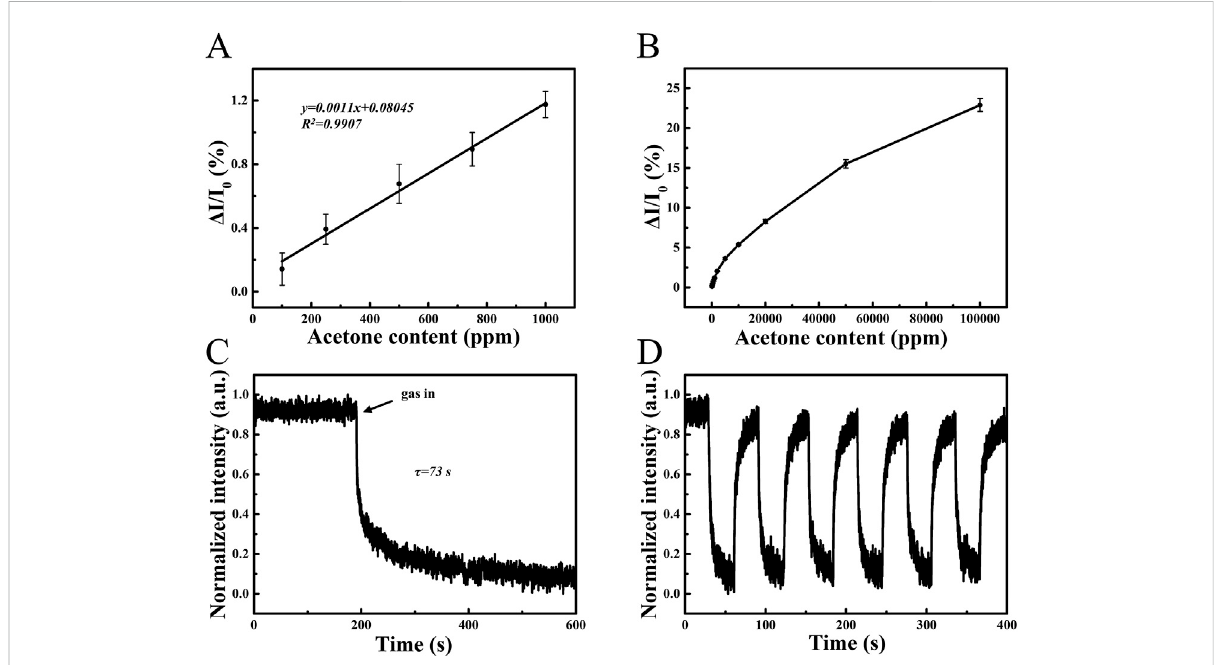
FIGURE 3 (A) Response curves of PS/TPMN samples in acetone vapor at low concentrations. Δ I/I 0 varies linearly with acetone concentration, demonstratingagoodlineardependencywithlowlimitofdetectionof100 ppm.Errorbars,s.d.( n =10); (B) ResponsecurvesofPS/TPMNsamplesin acetone vapor at 100 ppm-100000 ppm. Error bars, s.d. ( n = 10) (C) Single response curves of PS/TPMN samples in acetone vapor at 300000 ppm. The result indicates the sensor response time is 73 s; (D) Continuous multiple response curves of PS/TPMN samples in acetone vapor at 300000 ppm. Demonstrates good reproducibility and stability of the sensor.